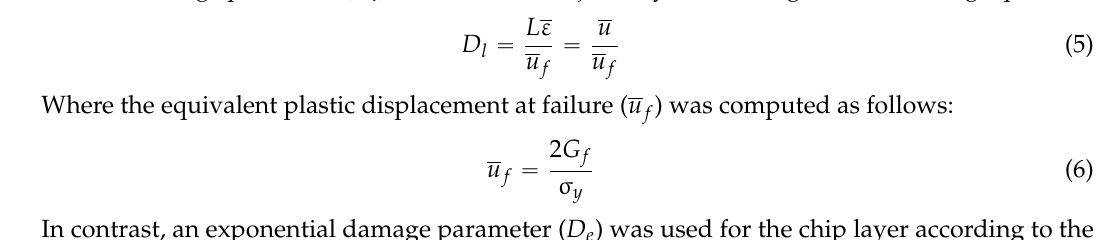
Table 4. In Table 4, σ 11 signifies the stress in the fiber direction, σ 22 denotes the stress in the transverse direction, and σ 12 represents the in-plane shear